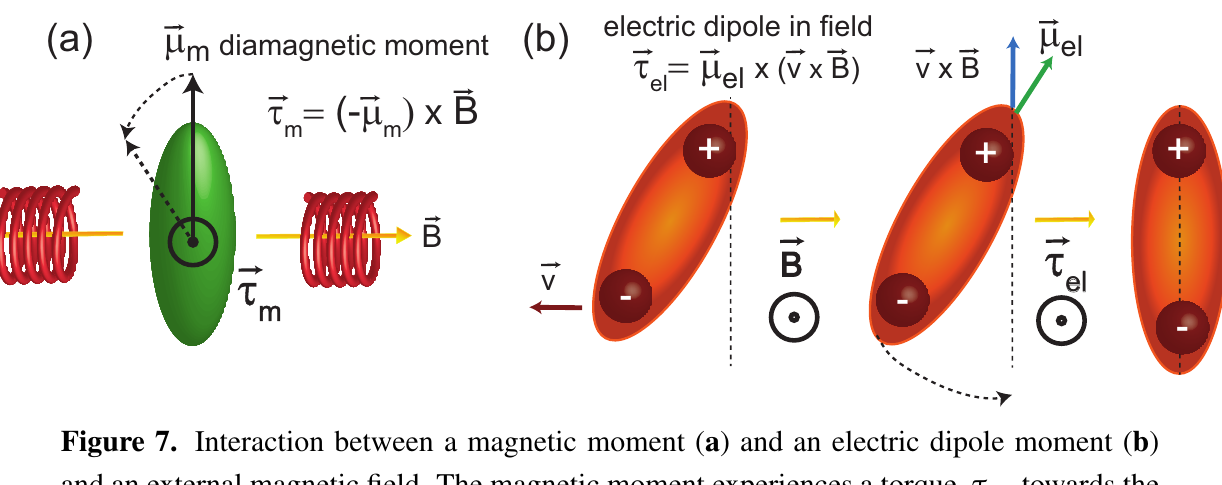
, towards the m = µ B = 5 × 10 − 32 J is small m m = k T = 4 × 10 − 21 J), the energy related to a thermal B = α τ = 3 . 3 × 10 − 20 J , comparable to el el